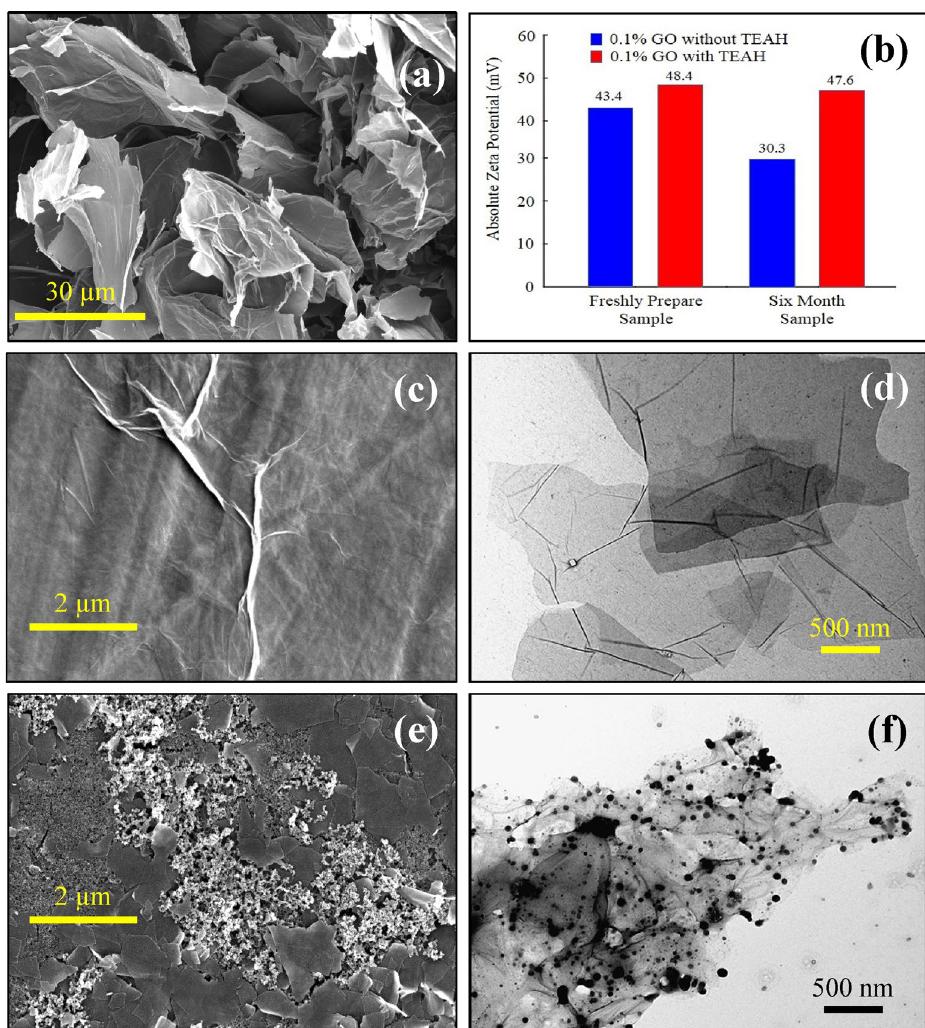
Figure 1. ( a ) FESEM image of GO prior to processing, ( b ) absolute zeta potential values for fresh nanofluid samples and those after 6 months storage, ( c ) FESEM and ( d ) TEM images of GO-based aqueous nanofluids and ( e ) FESEM and ( f ) TEM are images of RGO-based